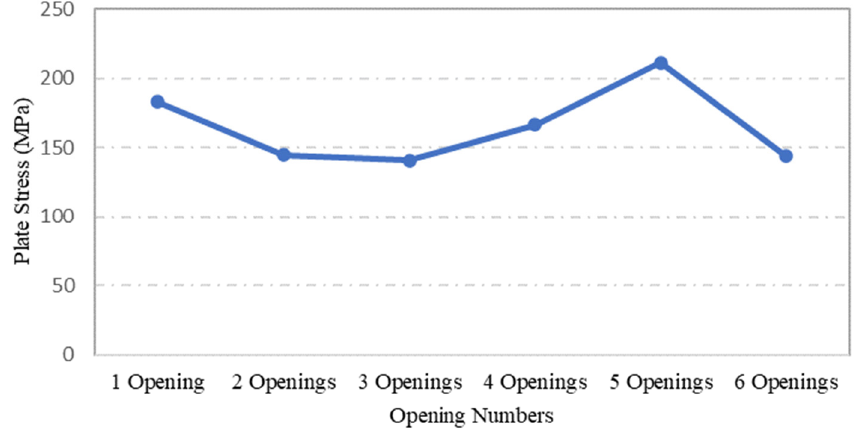
Figure 16. Influence of plate opening numbers on maximum stress.